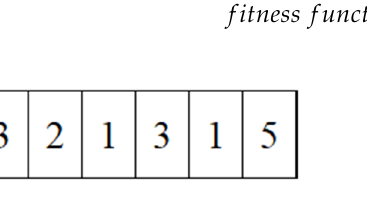
Figure 4. An example of the phenotype of a queen.